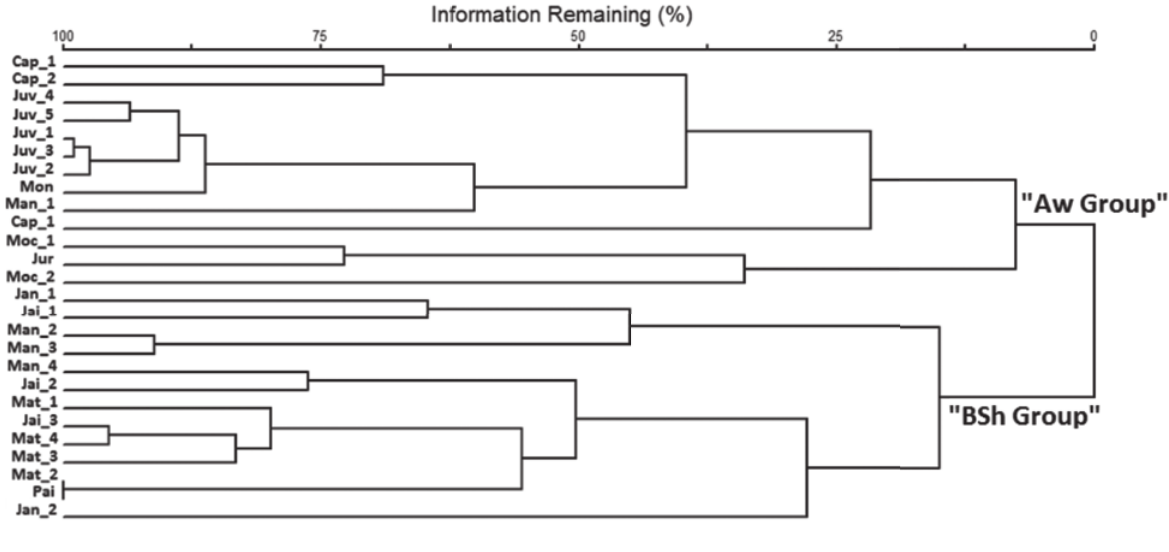
Figure 4 - Dendrogram of similarities between 26 areas of dry forest sensu stricto (DF) in northern Minas Gerais State, as formed by the agglomerative grouping analysis of 193 genera. The areas are identifi ed by the codes listed in the Figure 1. BSh and Aw correspond to semi-arid and seasonal tropical climate domain,